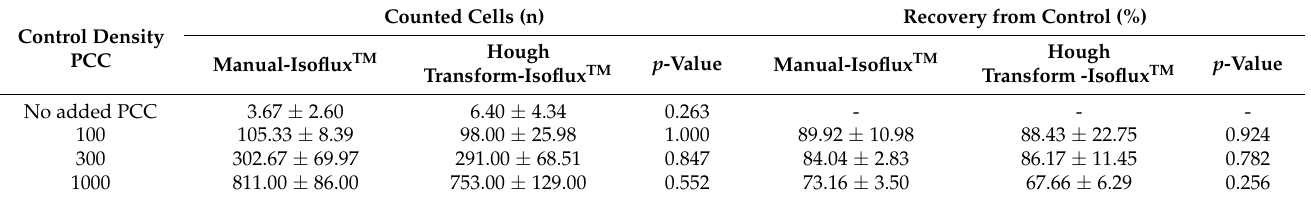
Table 1. Total counted PCCs with the Manual-Isoflux TM System and Hough-Isoflux TM System. Data are presented with the mean and S.D.